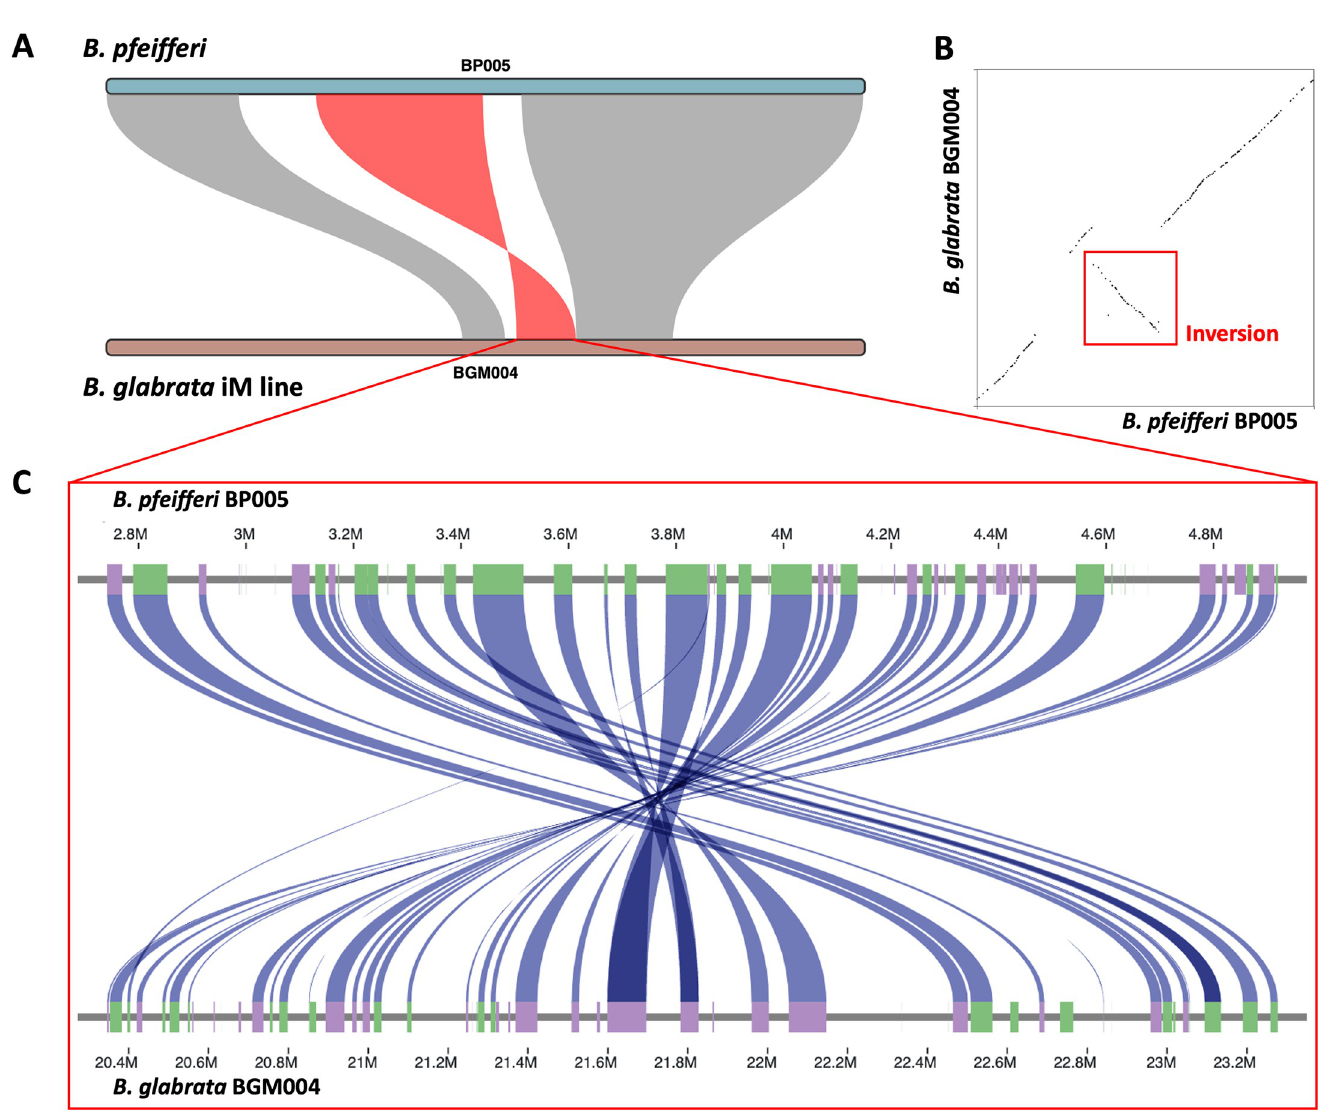
Fig 6. Inversion identified on inferred LG9 between B . pfeifferi and B . glabrata iM line genomes. A ) A 2.3 Mbp size inversion region was identified. The scaffolds covering the linkage groups are BP005 and BGM004, respectively. B ) Dot plots show the inversion area was between large flanking synteny blocks. C ) ShinySyn plot showing the sequence similar genes connected by blue ribbons, revealing the reverse order within the inverted region. Genes were marked in colored boxes along the x axes, purple boxes for positive strand and green boxes for negative strand. Boxes without connections are genes with no sequence similarity identified between the two